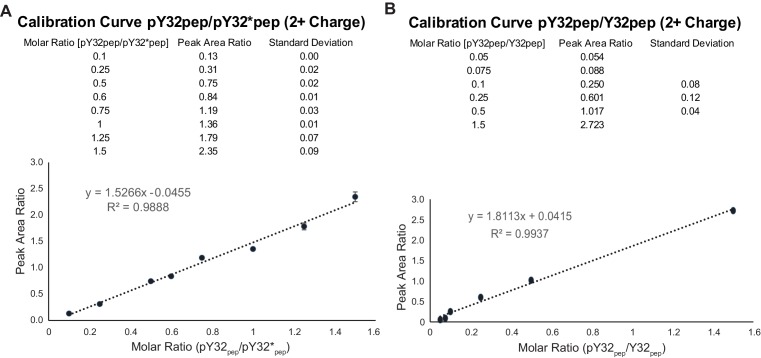
Peptide calibration curves.(A) Calibration curve for pY32 based on LC-MS/MS analysis. The results reflect the means and standard deviations of data acquired from three independent LC-MS/MS measurements. (B) Calibration curve for Y32 peptide. Refer to Figure 4—figure supplement 5—source data 1, 2 for calibration curve data. Refer to Figure 4—figure supplement 5—source data 3–6 for peptide quantification from Skyline analysis.10.7554/eLife.46043.021Figure 4—figure supplement 5—source data 1.Standard curve for quantification of pY32 peptide relative to pY32* peptide in LynA immunoprecipitates.10.7554/eLife.46043.022Figure 4—figure supplement 5—source data 2.Standard curve for quantification of pY32 peptide relative to Y32 peptide in LynA immunopr.10.7554/eLife.46043.023Figure 4—figure supplement 5—source data 3.Quantification of pY32 peptide in nonUb LynA in resting BMDMs.10.7554/eLife.46043.024Figure 4—figure supplement 5—source data 4.Quantification of pY32 peptide in polyUb LynA in resting BMDMs.10.7554/eLife.46043.025Figure 4—figure supplement 5—source data 5.Quantification of pY32 peptide in nonUb LynA in 3-IB-PP1-treated BMDMs.10.7554/eLife.46043.026Figure 4—figure supplement 5—source data 6.Quantification of pY32 peptide in polyUb LynA in 3-IB-PP1-treated BMDMs.